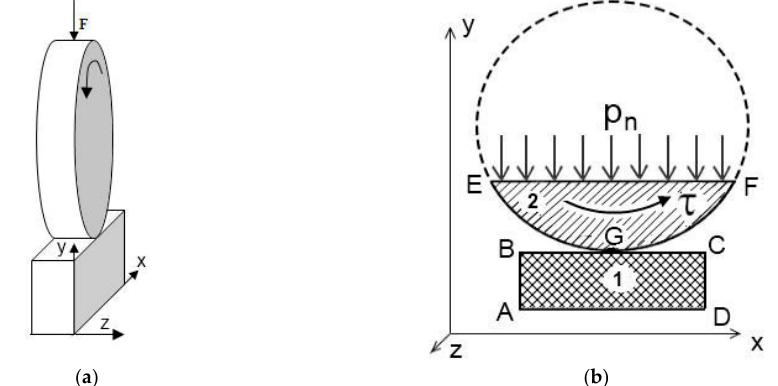
Figure 1. Schemes of the mechanical loading during friction ( a ) and computational domain ( b ).